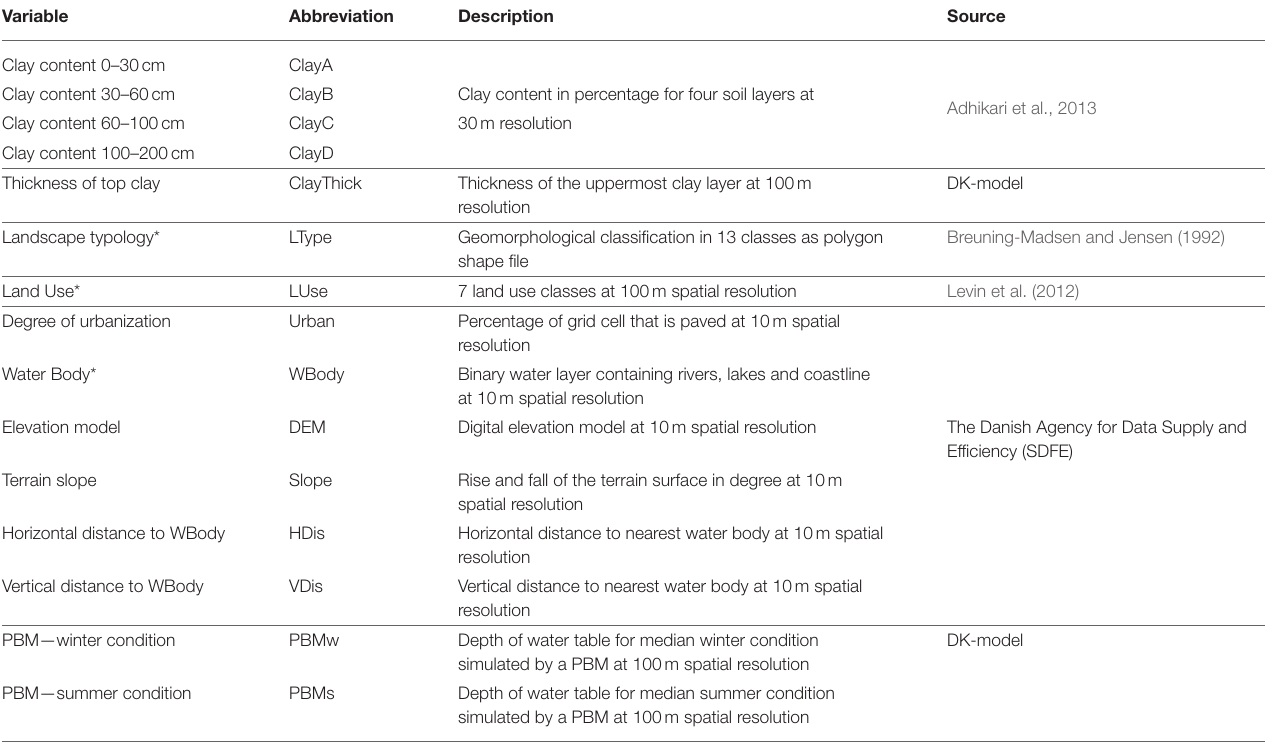
TABLE 2 | Overview of the explanatory variables used to model the uppermost water table.